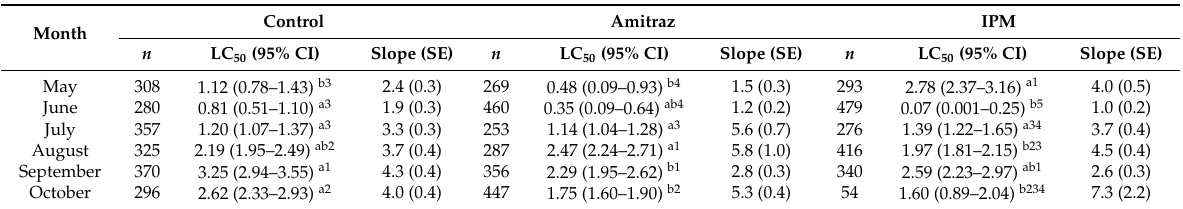
Table 3. Honey bee clothianidin bioassay summary. The LC 50 values are in shown in units of ng clothianidin/mL/mg bee. The LC 50 values were considered significantly different if the 95% CI of the LC 50 values did not overlap between colonies or test dates. Letters and numbers beside LC 50 values indicate significant differences in rows and columns,